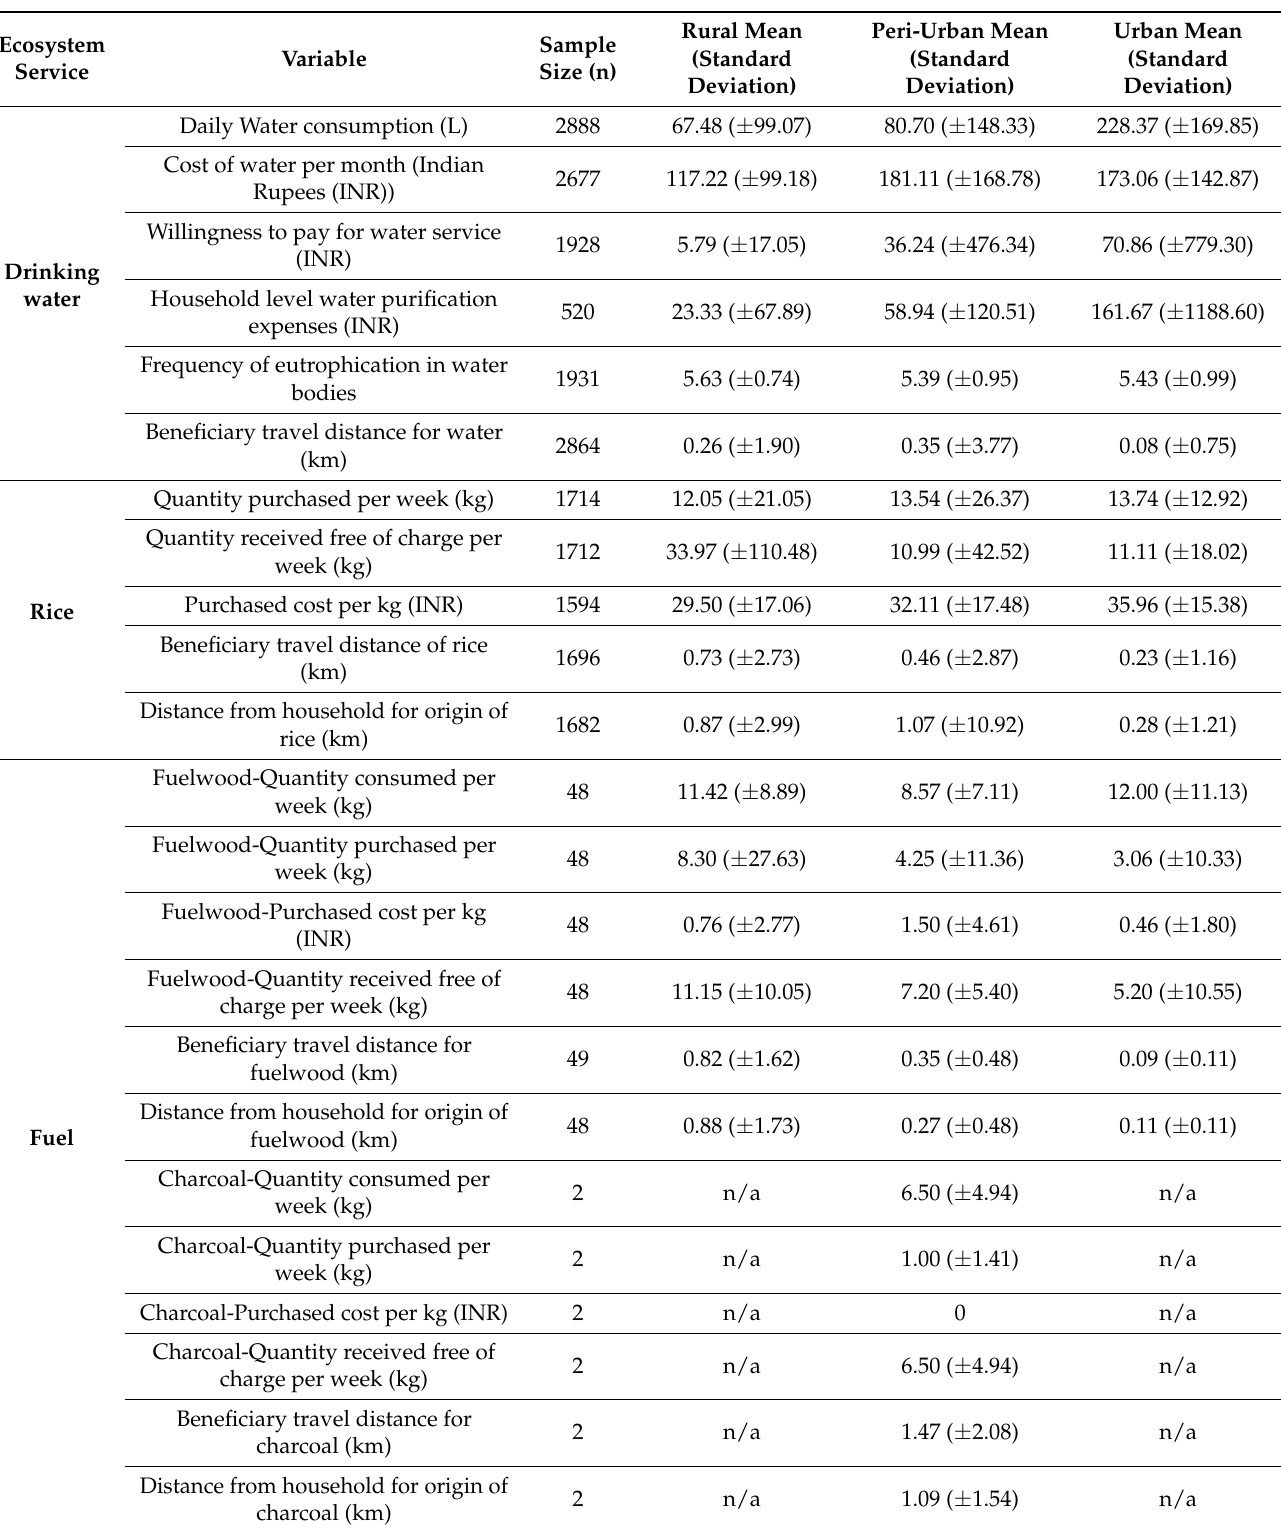
Table 1. Descriptive statistics of the ecosystem service